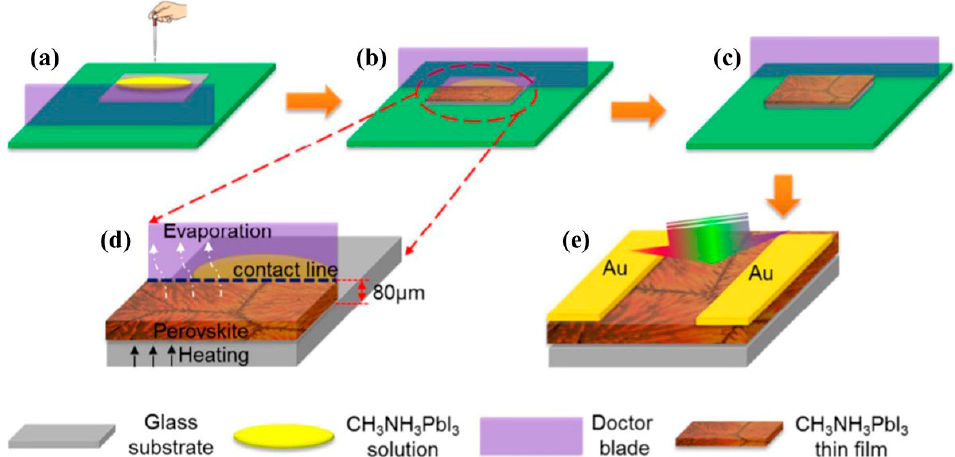
Figure 8. Schematic diagram of the in-situ doctor blading method for fabricating CH 3 NH 3 PbI 3 films. ( a ) CH 3 NH 3 PbI 3 solution dropped before the doctor blade is brought close to the substrate. ( b ) CH 3 NH 3 PbI 3 crystal nucleate and growth during doctor blading. ( c ) The magnified schematic in ( b ). ( d ) CH 3 NH 3 PbI 3 crystal film is growing with the movement of the doctor blade, and large-area CH 3 NH 3 PbI 3 film was formed on the substrate. ( e ) Schematic of CH 3 NH 3 PbI 3 photodetector synthesized through doctor blading [111]. Copyright 2017 Elsevier.